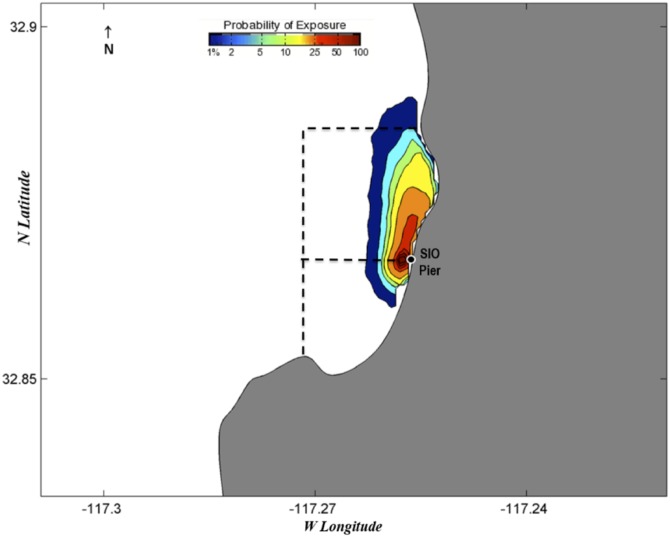
Probability map of predicted fish egg dispersal prior to collection: June 16–19, 2014.Dotted lines depict the boundaries of the MPAs: the San Diego-Scripps SMCA to the north and the Matlahuayl SMR to the south.